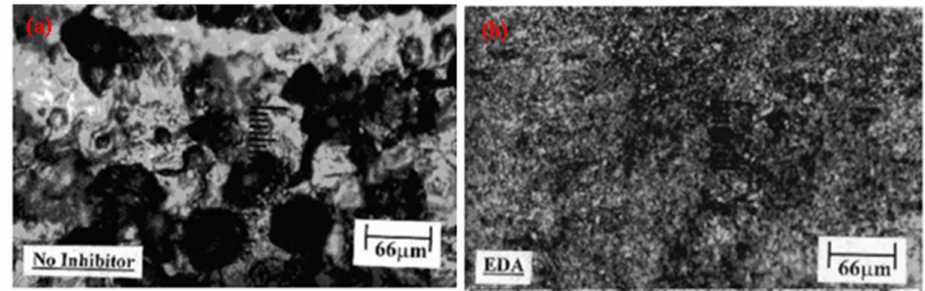
Figure 10. Optical micrographs showing ( a ) pitting (without inhibitor) and ( b ) adsorbed layer by